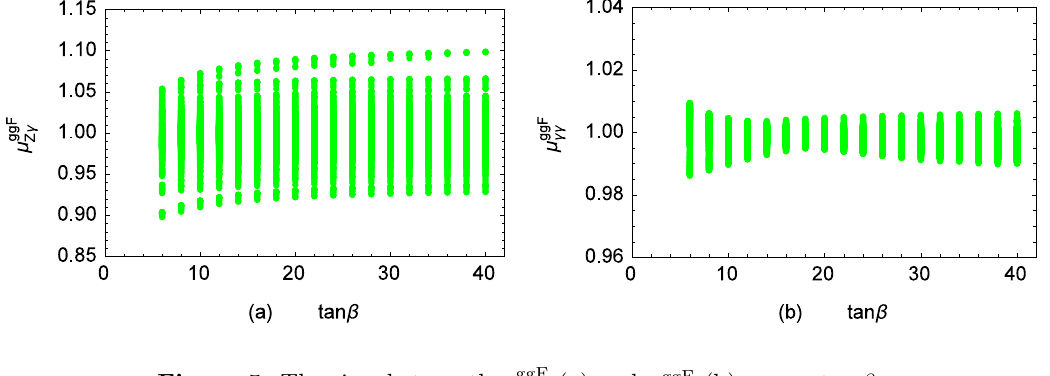
(a) and (cid:22) ggF (b) versus tan (cid:12) . (cid:13)(cid:13) Z(cid:13)